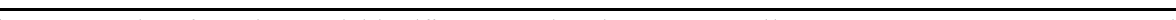
Fig. 2 catFISH analysis of BA and PrL revealed that different neuronal populations are activated by a new tone or CS presentation. a catFISH analysis in the basal amygdala (BA). The section diagram was drawn on the basis of our DAPI-stained sections. CE central amygdala, LA lateral amygdala. b Representative images showing single-labeled H1a (green arrows)- and Arc (red arrows)-expressing cells, and double-labeled cells (yellow arrows) in the naive ( n = 5), 7 kHz D (discriminators, n = 5), 3 kHz ( n = 5) and 1 kHz ( n = 5) groups. Scale bar, 20 µ m. c In BA, following new tone and CS presentation, the percentage of H1a- or Arc- expressing cells was higher in the 7 kHz D group than in other groups ( F (3, 16) = 19.57, P < 0.001 (left); F (3, 16) = 16.41, P < 0.001 (middle); F (3, 16) = 23.67, P < 0.001 (right)). d Total rates of H1a ( F (3, 16) = 19.44, P < 0.001) or e Arc ( F (3, 16) = 20.78, P < 0.001) were lower in the naive than in the other groups. f Scaled Venn diagrams showing the percentage of H1a (green), Arc (red), and H1a + Arc (yellow) expressing neurons in BA in the different behavioral groups. The neuronal populations activated during both new tone or CS presentation in 7 kHz D group were less overlapping with respect to other groups. g catFISH was performed in the layers II-III of the prelimbic cortex (PrL). The section diagram was drawn on the basis of our DAPI- stained sections. h Images showing H1a and Arc nuclear expression in the naive, 7 kHz D and 1 kHz groups. i In PrL, the percentages of cells single-labeled for H1a or Arc were signi fi cantly higher in the 7 kHz D group than in the naive and 1 kHz groups ( F (2, 9) = 44.82 (left), P < 0.001; F (2, 9) = 9.91, P < 0. 01 (middle)). Conversely, the percentage of double-labeled cells was lower in both the 7 kHz and the naive group than in the 1 kHz group ( F (2, 9) = 13.55, P < 0. 01 (right)). j The total rates of both H1a ( F (2, 9) = 9.76, P < 0. 01) and k Arc ( F (2, 9) = 10.93, P < 0. 01) were lower in the naive group than in the 7 kHz D and 1 kHz groups. l In PrL, scaled Venn diagrams indicated that in 7 kHz D group the neuronal populations activated during new tone or CS presentation were less overlapped with respect to other groups. * P < 0.05, ** P < 0.01, *** P < 0.001. All data are mean and SEM. One-way ANOVA with Newman – Keuls